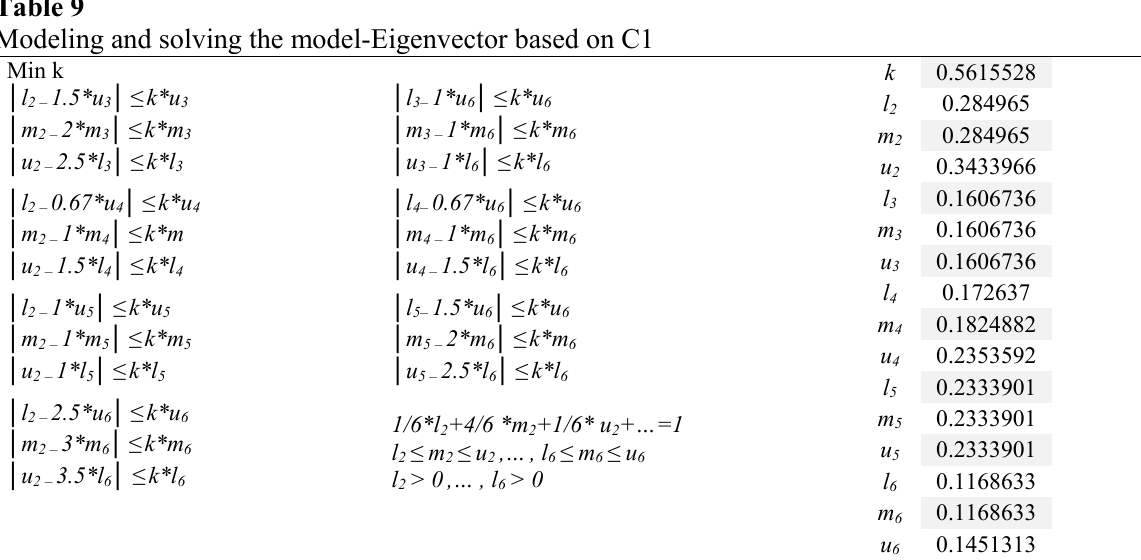
Modeling and solving the model-Eigenvector based on C1 Min k